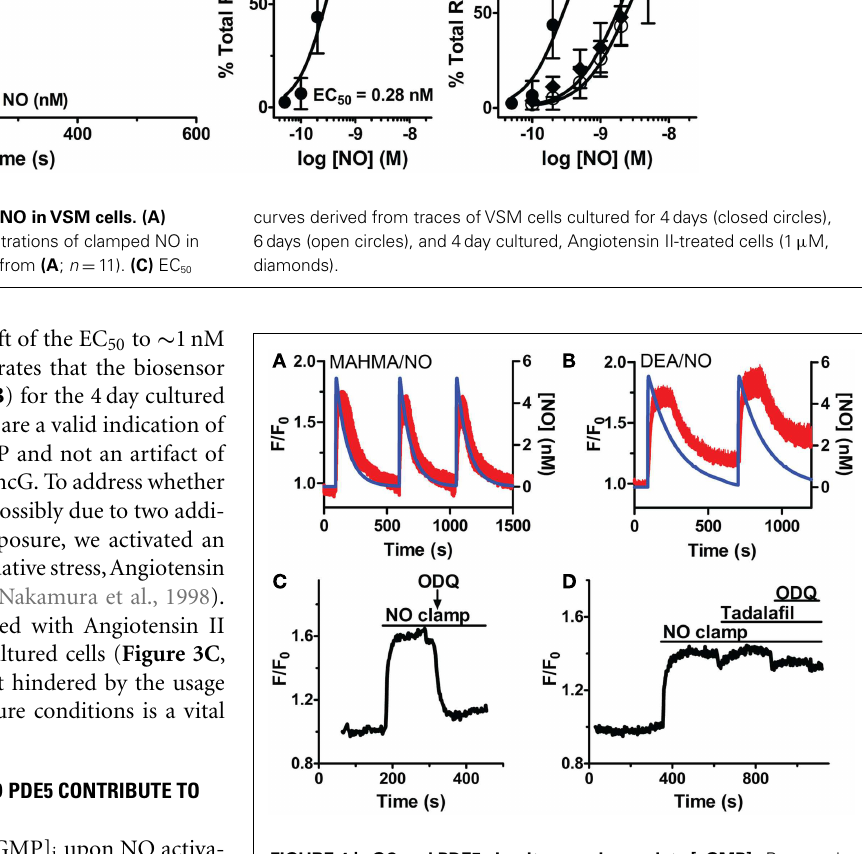
FIGURE 4 | sGC and PDE5 simultaneously regulate [cGMP] i . Repeated pulses of 5nM NO using (A) MAHMA/NO (200nM + 50 µ M CPTIO, n = 5) and (B) DEA/NO (400nM + 50 µ M CPTIO, n = 6). Shown is the average mean value and standard deviation of FlincG-transfectedVSM cells for several experiments in red, calculated NO concentration in blue. (C,D) Representative traces depicting decreased [cGMP] i upon 10 µ M ODQ application in the presence of clamped 5nM NO (Spermine/NO, C), n = 4 and persistently elevated [cGMP] i upon tadalafil (1 µ M) and ODQ (10 µ M) treatment, n = 7 (D)